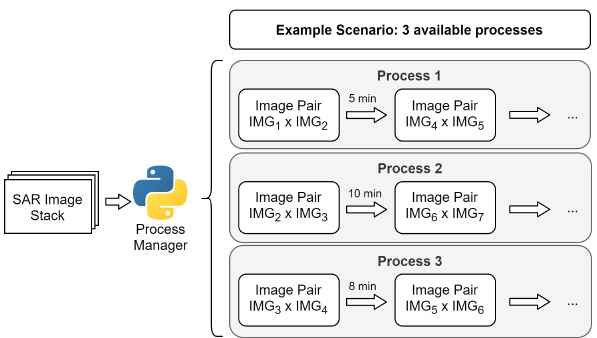
Figure 7. Illustration of the horizontal scalability approach used to process S1 or RCM image